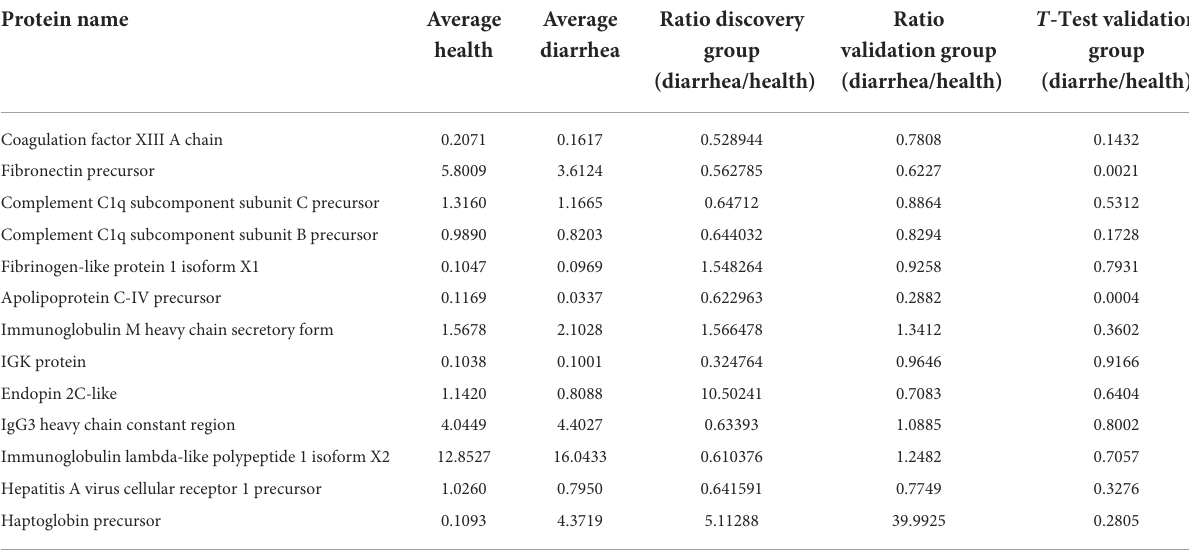
TABLE 5 Differential proteins identified in plasma samples of DHD calves and clinically healthy calves by